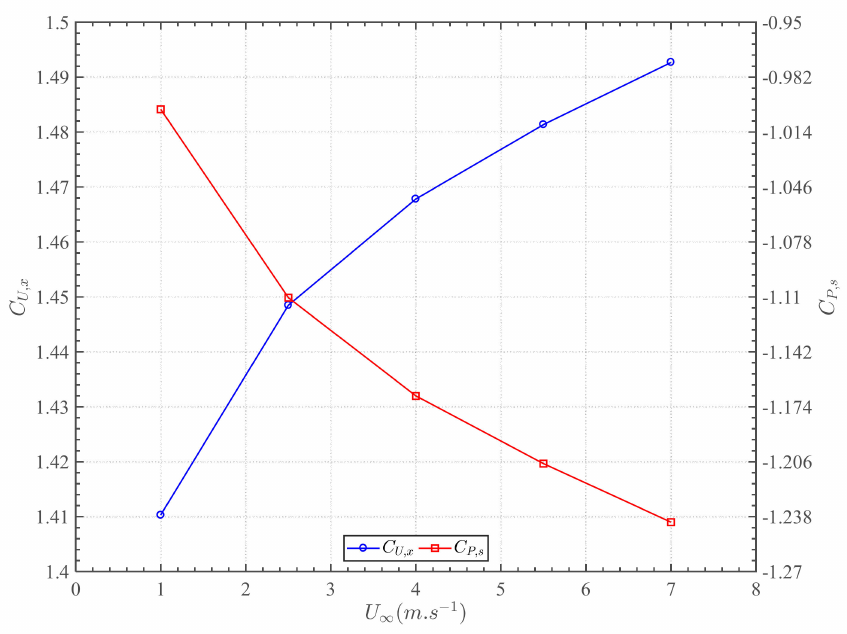
Figure 7. Evaluation of the throat axial velocity coefficient ( C U , x ) and static pressure coefficient ( C P , s ) with free-stream velocity ( U ∞